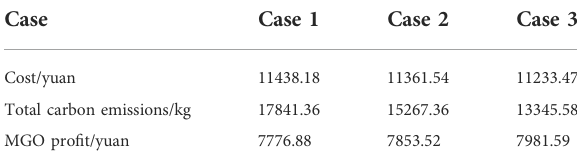
TABLE 1 Case 1: comparison of cost using the Stackelberg game.